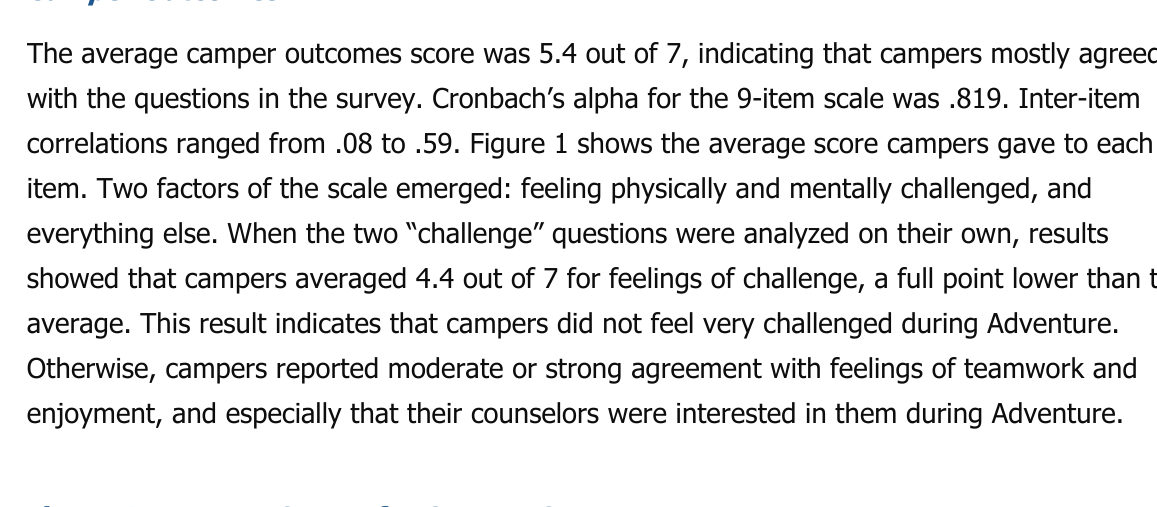
Figure 1. Average Scores for Camper Survey